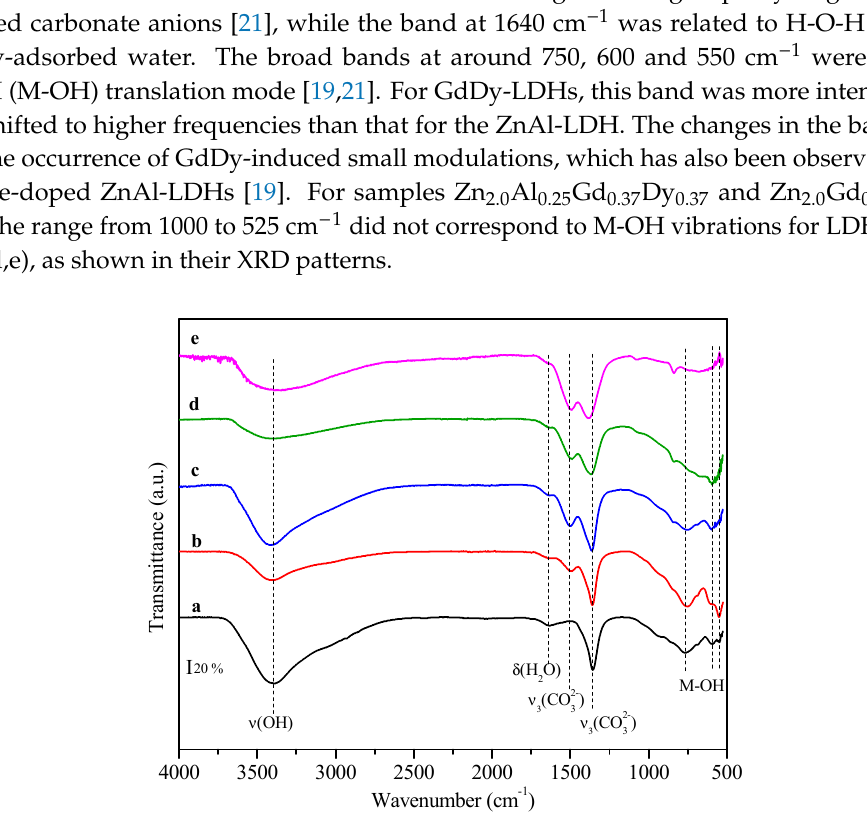
Figure 2. FT-IR spectra of the samples: ( a ) Zn 2.0 Al 1.0 , ( b ) Zn 2.0 Al 0.75 Gd 0.125 Dy 0.125 , ( c ) Zn 2.0 Al 0.5 Gd 0.25 Dy 0.25 , ( d ) Zn 2.0 Al 0.25 Gd 0.37 Dy 0.37 and ( e ) Zn 2.0 Gd 0.5 Dy 0.5.